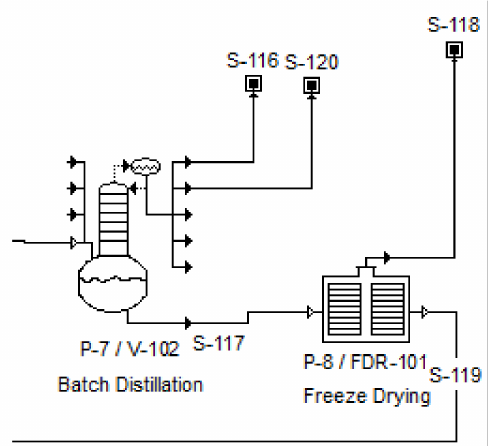
Figure 3. The evaporation and freeze-drying process of longevity spinach